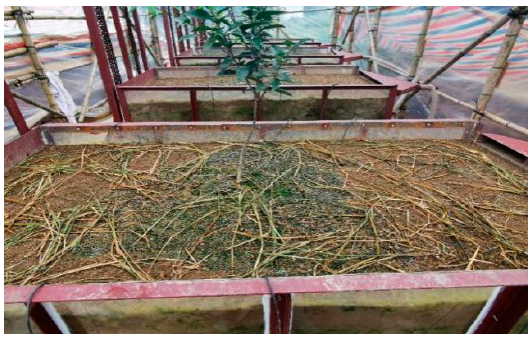
Figure 2. Overview of citrus tree soil